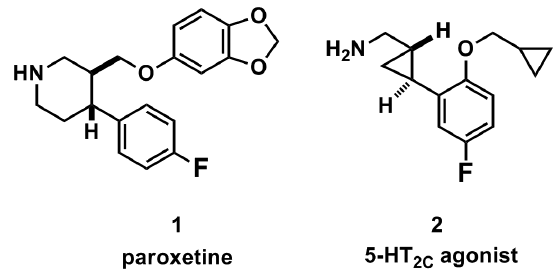
Figure 1. Two small molecule aryl fluorides chosen for radio- fluorination and non-human primate PET imaging presented here.